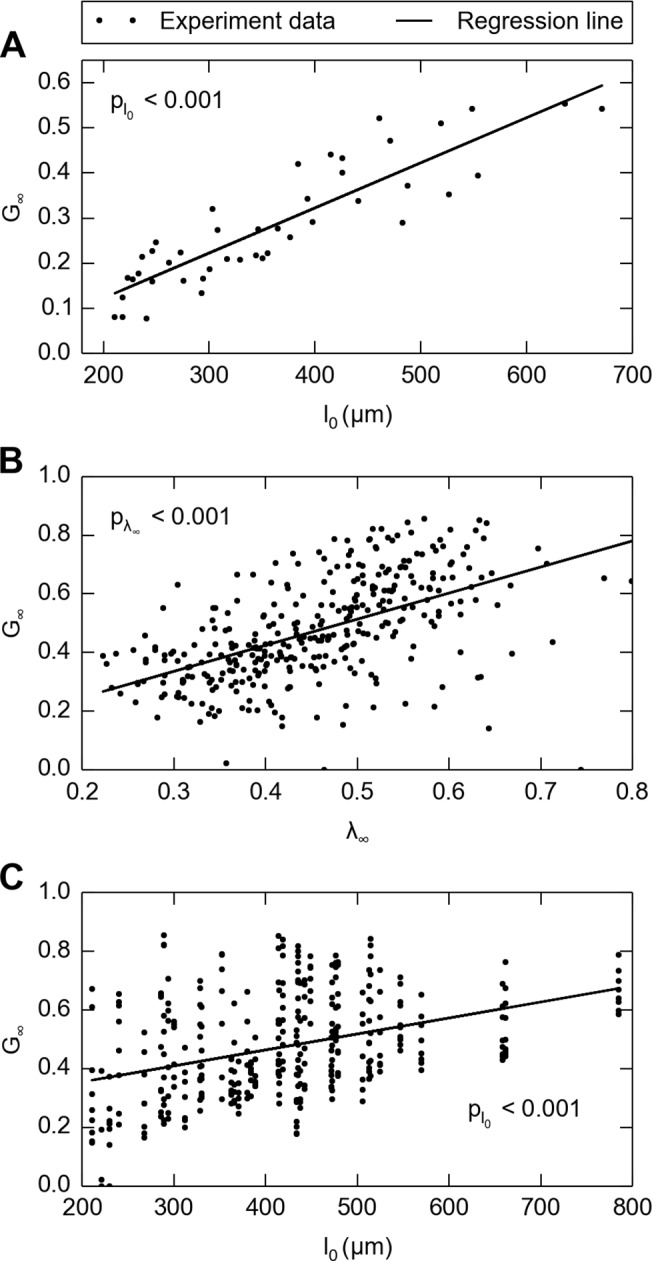
Correlations between skin thickness/stretch level and residual stress ratio (G
∞).A: In the first experiment where only thickness varied, the steady-state residual stress ratio (G
∞) correlates with increasing skin thickness, n = 44. Linear regression (solid line) with residual stress ratio G
∞ as the dependent variable was performed, which returns p < 0.001 for independent variable thickness l
0, and G
∞ = 9.997 × 10−4 μm−1 ⋅ l
0 + 0.077. In the second experiment where both thickness and strain level varied, the residual stress ratio (G
∞) correlates with both B: stretch and C: skin thickness. Note that the two correlations are independent from each other because there is no correlation between stretch and skin thickness. Multilinear regression with residual stress ratio G
∞ was also performed, which returns p < 0.001 for independent variable stretch λ
∞, p < 0.001 for independent variable thickness l
0, and G
∞ = 0.810 ⋅ λ
∞ + 4.25 × 10−4 μm−1 ⋅ l
0–0.074. Note that in B and C, solid lines are single-linear regressions for residual stress ratio with respect to stretch and thickness respectively.